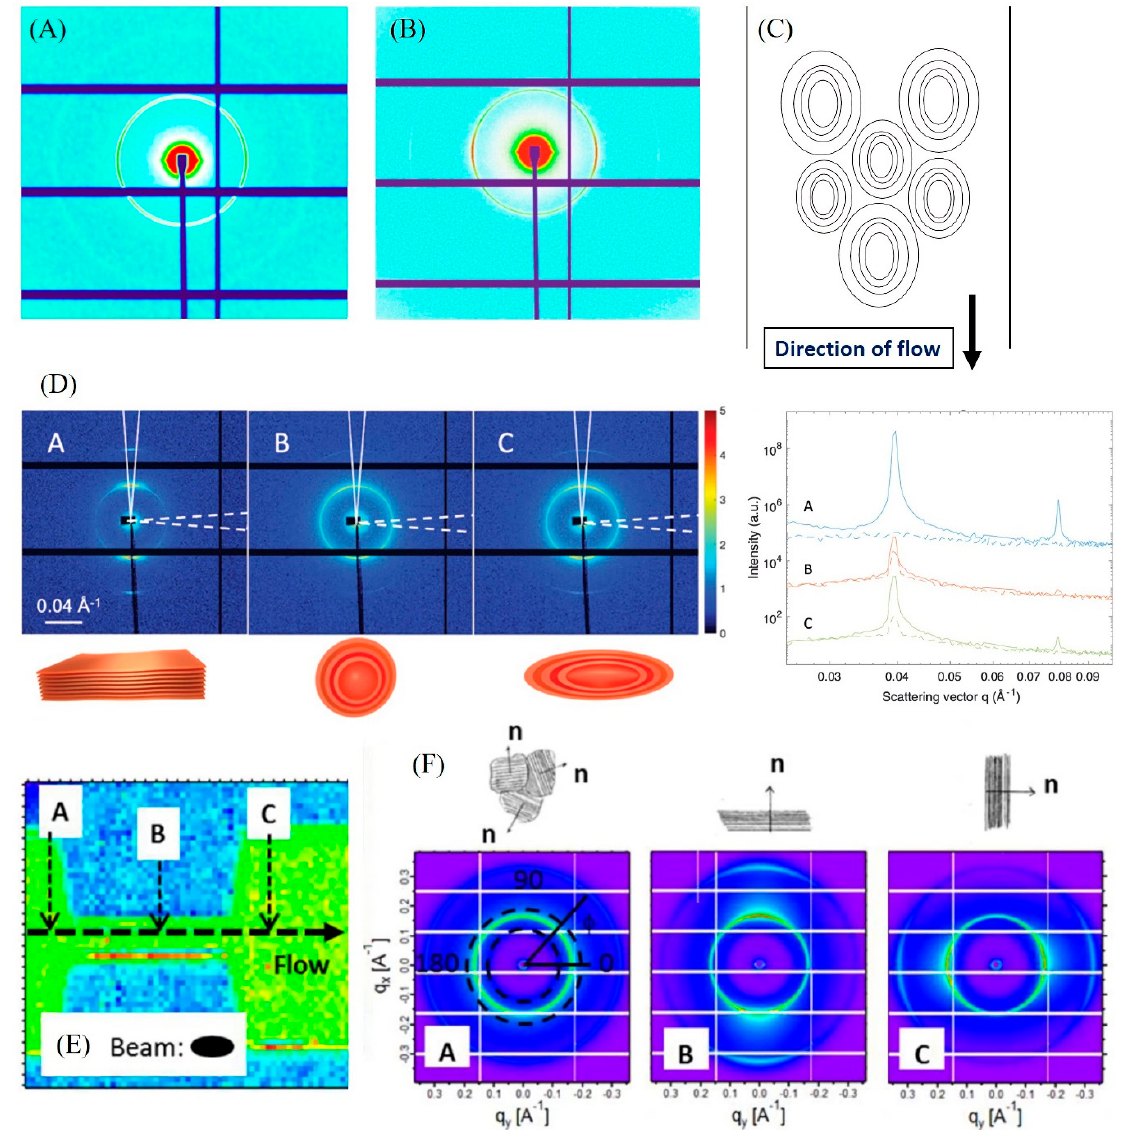
Figure 4. ( A ) 2D isotropic SAXS pattern during the formation of MLVs at TFR of 5 μ L/min. ( B ) A light alignment of the MLVs (slightly distorted) at relatively high TFR (>15 μ L/min). Slightly anisotropic SAXS pattern, indicating a slight deformation of the continuously produced MLVs as illustrated in ( C ). Panels ( A – C ) reprinted with permission from [31]. 2017, the American Chemical Society. ( D ) Left: 2D SAXS patterns of lamellar structures in three areas (A–C) with different orientations: an aligned lamellae structure, MLVs, and stretched MLVs in the flow direction. Right: Corresponding radial SAXS profiles in the three areas (A–C). Adapted with permission from [74]. 2021, Wiley. ( E ) SAXS measurements at the positions A–C along the centerline of the microchannel. ( F ) 2D SAXS patterns at three measurement positions (A–C): an isotropic pattern at position A; whereas a strong anisotropy was detected at positions B and C, indicating bilayers alignment upon entering the microfluidic constriction and upon exiting, respectively. Panels ( E ) and ( F ) reprinted with permission from [71]. 2016, the American Chemical Society.